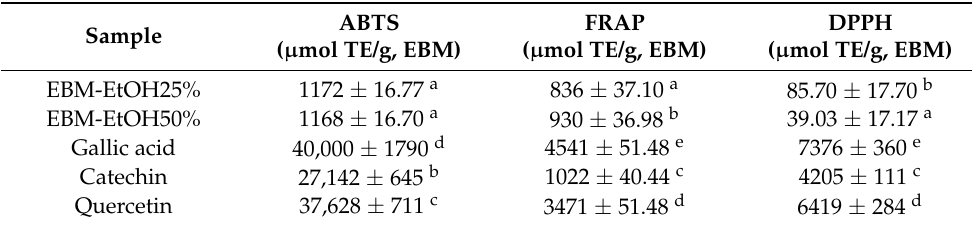
Table 5. Antioxidant activity of extract Baccharis macrantha (EBM) by ABTS, FRAP and DPPH